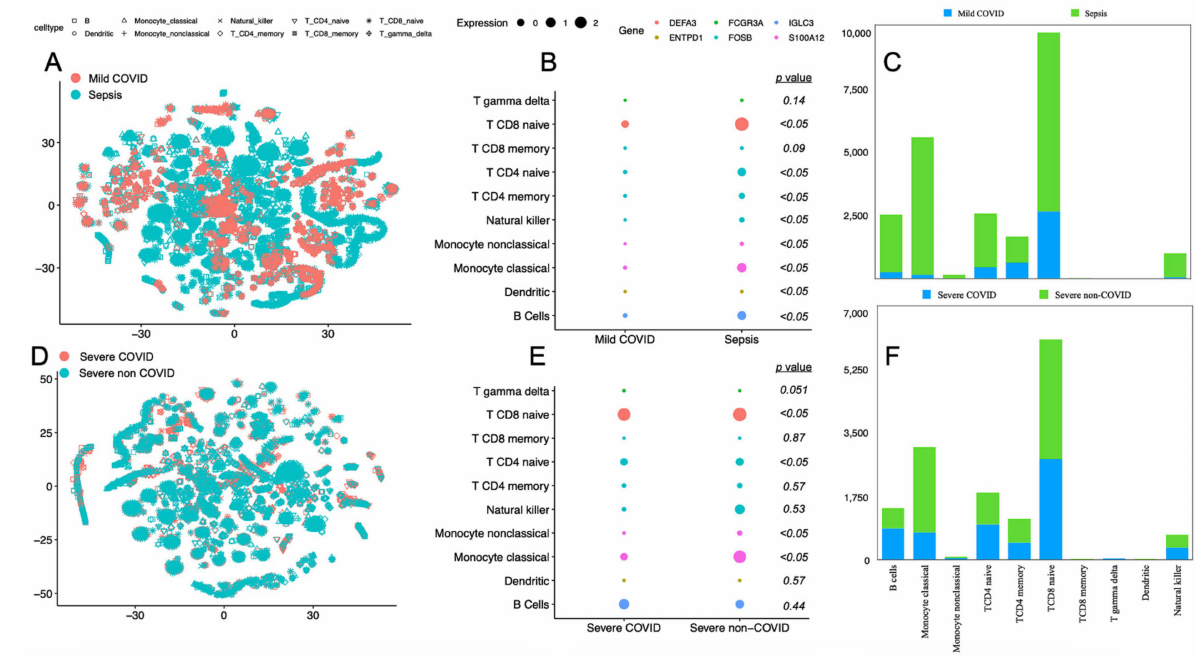
Figure 3. Single cell RNA-seq profile of severe and non-severe patients with viral and bacterial sepsis. We show t-SNE plots of 10 immune cells expressing 400 different genes in ( A ) mild COVID and sepsis patients and ( D ), severe COVID and septic shock patients. The dimensionality reduction achieved with t-SNE in order to bring 400 genes expression rate to two dimensions (x and y) considered a perplexity value of 30. Next, in ( B , E ), we, performed a Principal Component Analysis (PCA), targeted the gene that most contributes to the variance of a subset of the data composed only by one cell type. The measuring of the loading scores indicated the genes that best explain the first component of the PCA. Data distribution was assessed with the Shapiro Wilk test encompassing each disease model (COVID and non-COVID) and its severity (severe and non-severe). Then, the means of each two genes were compared either with a t test or Wilcox rank test. The full description of the p values is included in Supplementary Material S1. In ( C , F ) we accounted for the number of cells of each cell type identified by the single cell